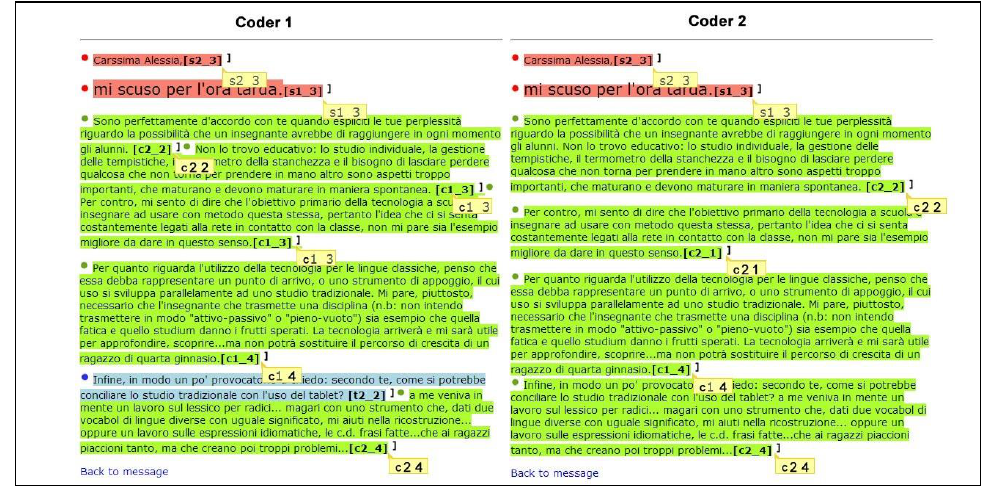
Figure 3. Screenshot of the tool for message coding (comparison between Coder 1 and